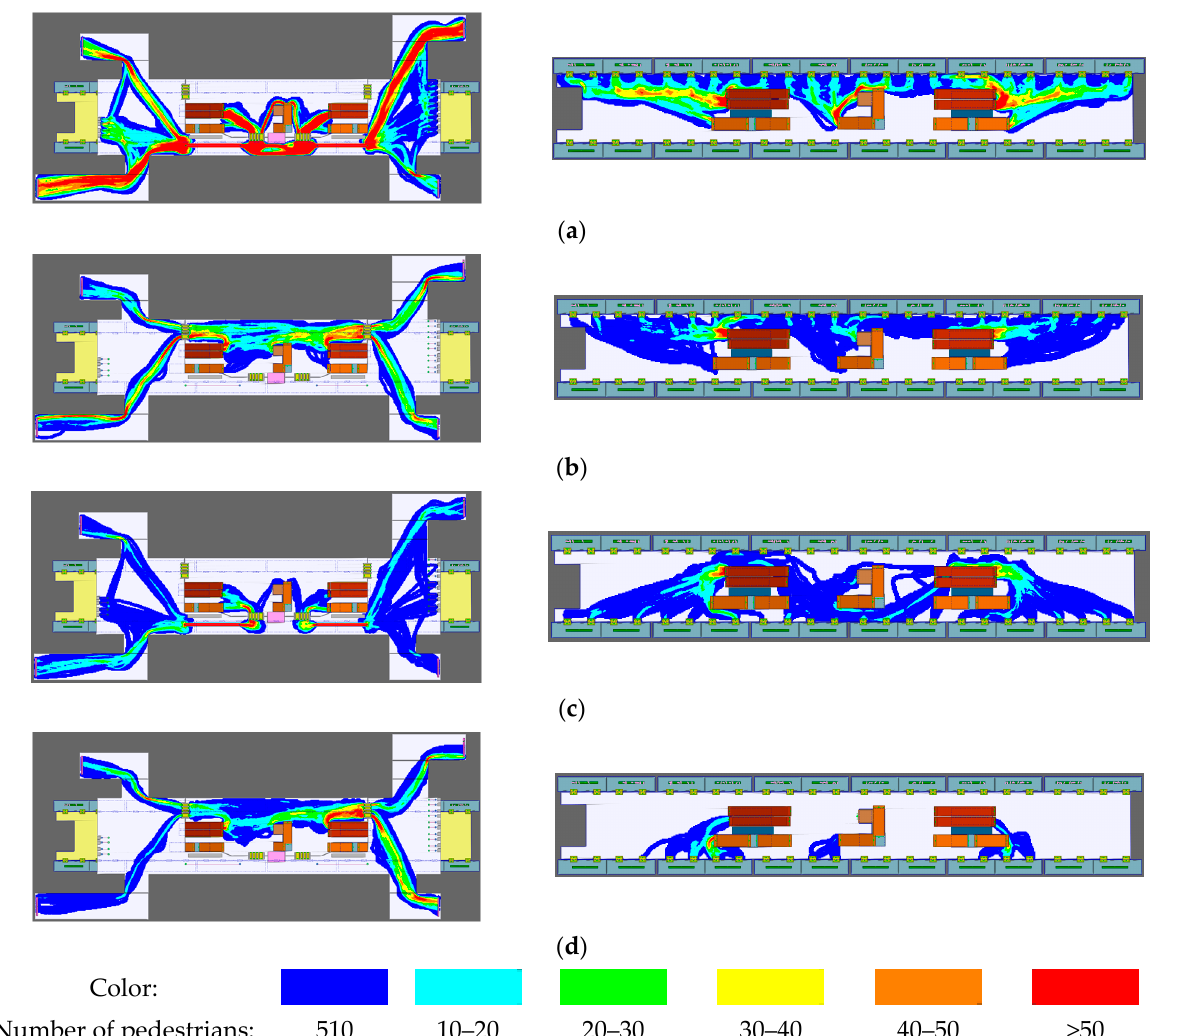
Figure 8. Space utilization analysis results for boarding and alighting pedestrians in different directions: ( a ) CD side boarding; ( b ) CD side alighting; ( c ) AB side boarding; ( d ) AB side alighting.